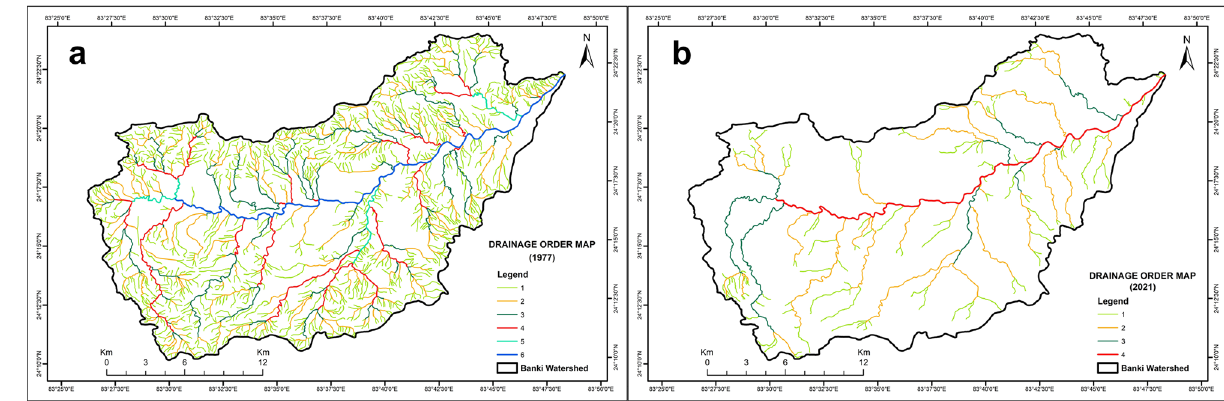
Figure 1. Drainage order map. ( a ) Reference drainage order map extracted from Survey of India toposheet (1977). ( b ) Delineation of drainage order map after ground truth verification of existing streams in 1 km × 1 km grided Banki watershed (2021).